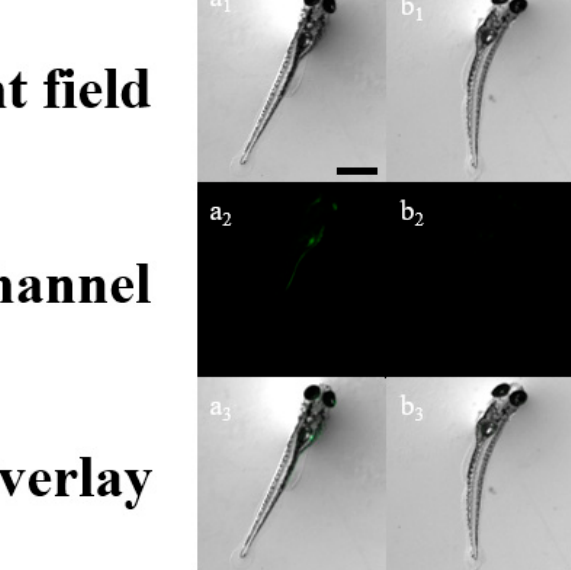
Figure 8. Fluorescence images of zebrafish treated with BK followed by addition of ClO − ( λ ex = 502 nm and λ em = 526 nm). ( a 1 – a 3 ): BK only; ( b 1 – b 3 ): BK with 5 × 10 − 5 M ClO − . [ BK ] = 2 × 10 − 5 M. Scale bar: 0.89 mm.